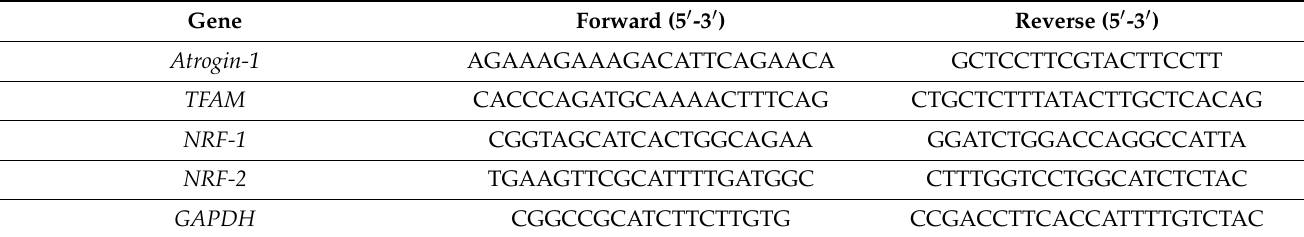
Table 1. List of primer sequences used for